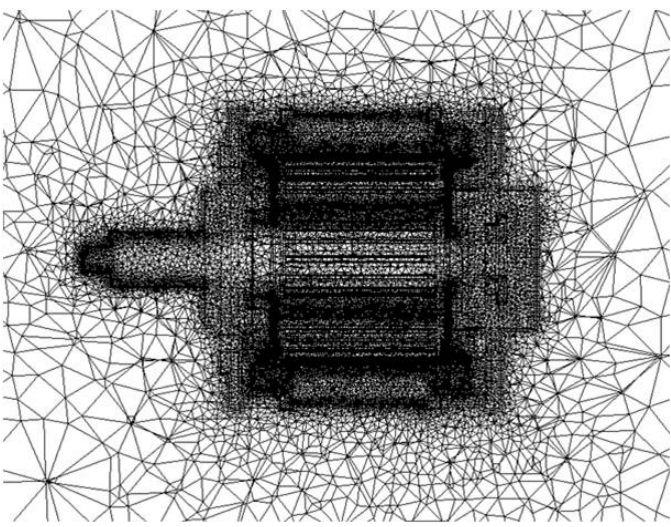
Figure 3. Grid model of the entire